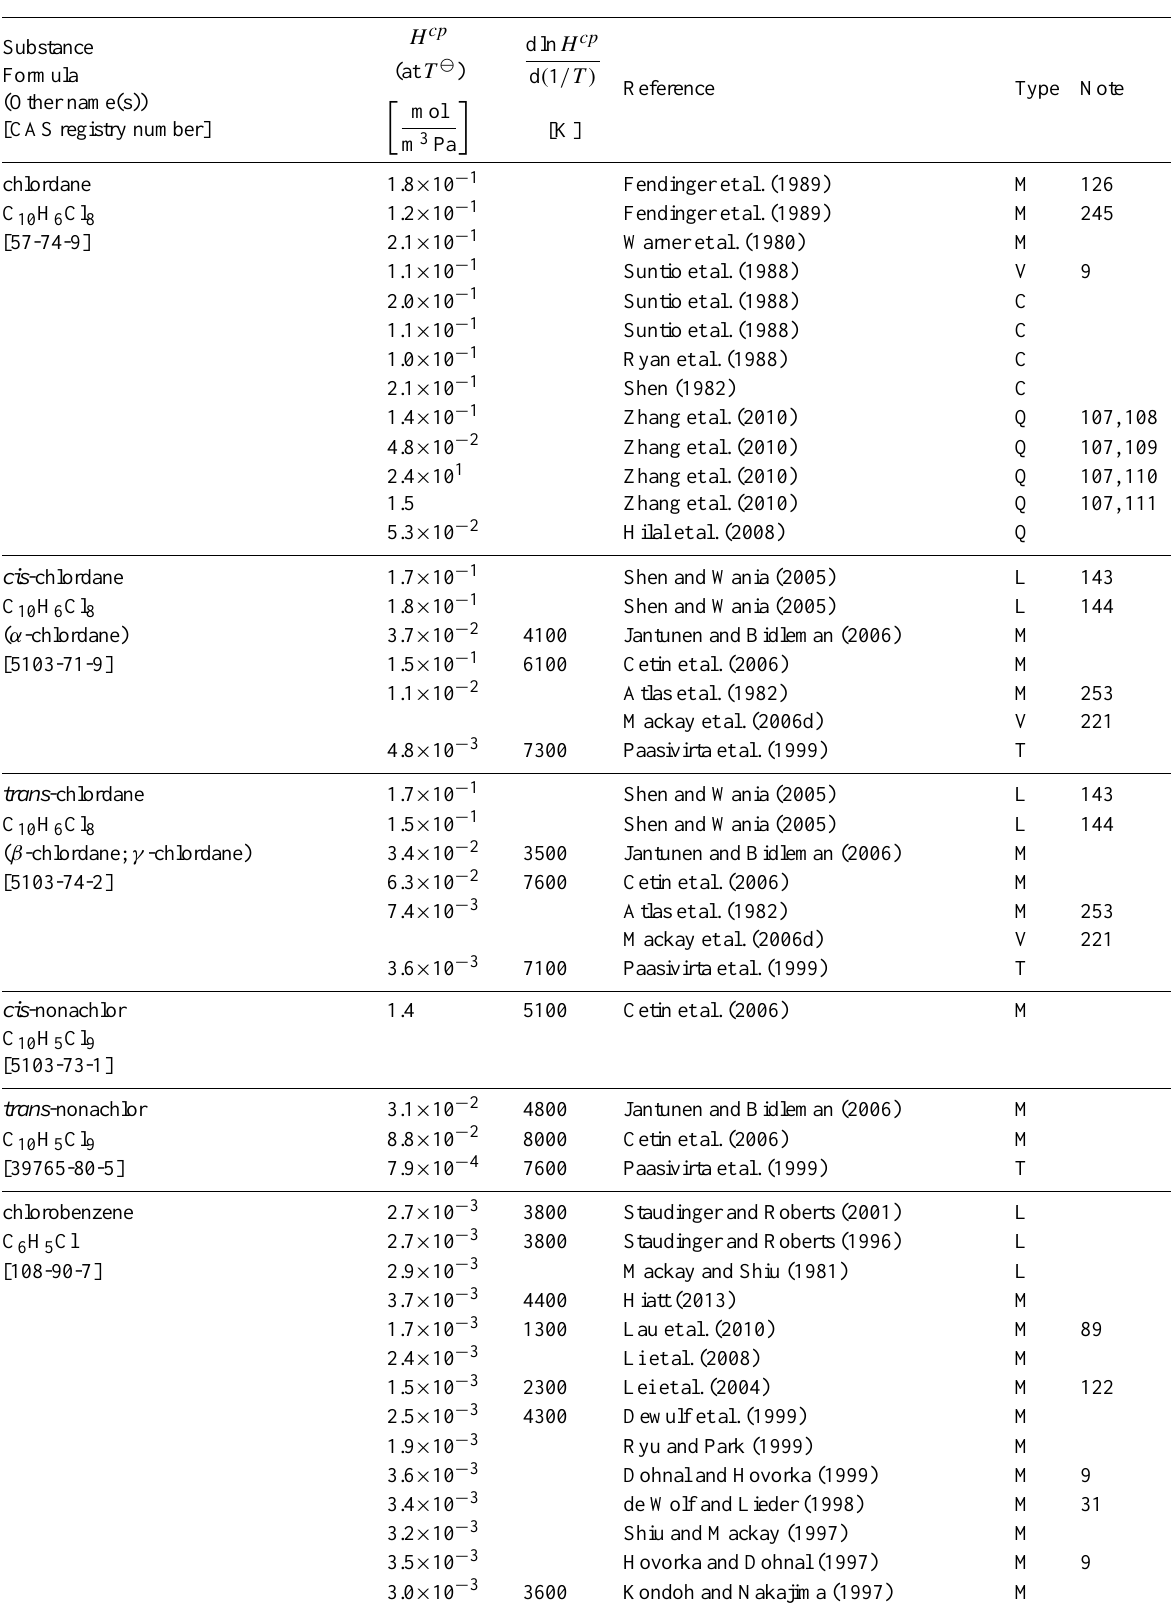
Table 6: Henry’s law constants for water as solvent